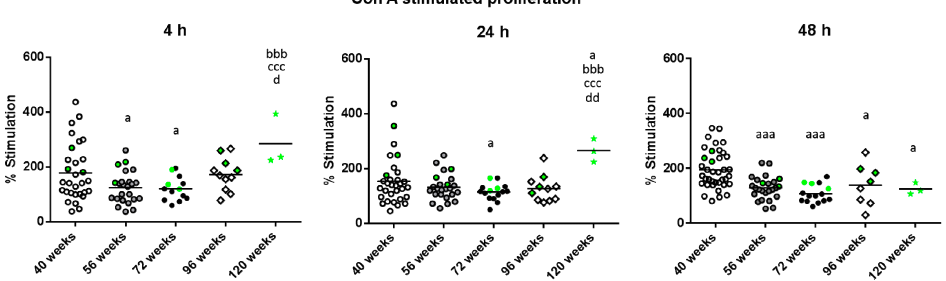
Figure 1. Stimulation of proliferation, expressed as percentages, in response to Con A (1 µ g/mL), of peritoneal leukocytes from adult (40 weeks), mature (56 weeks), old (72 weeks), very old (96 weeks) and long-lived (120 weeks) mice after 4, 24 and 48 h of culture. The green points represent the values in mice that reached 120 weeks. a: p < 0.05; aaa: p < 0.001 with respect to the value in adult mice. bbb: p < 0.001 with respect to the value in mature mice. ccc: p < 0.001 with respect to the value in old mice. d: p < 0.05; dd: p < 0.01 with respect to the value in very old mice.